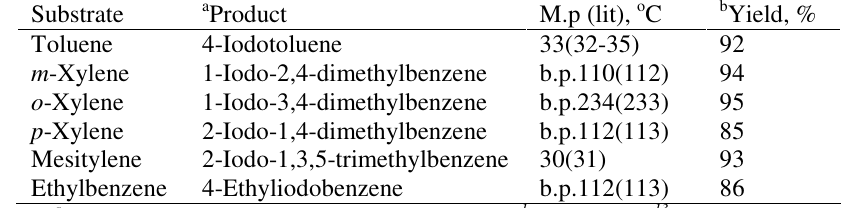
Table 1. Iodination of alkyl benzenes with benzyltriphenylphosphonium dichromate and iodine.